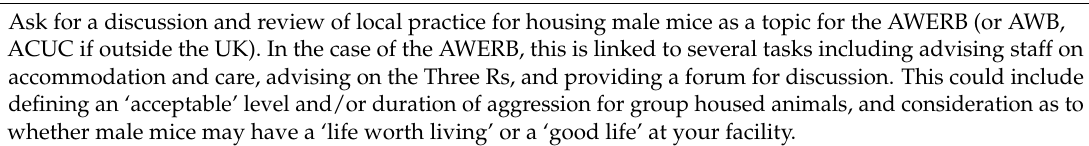
Table 6. Action Points for Animal Technologists, Researchers, Veterinarians, and AWERB/ACUC